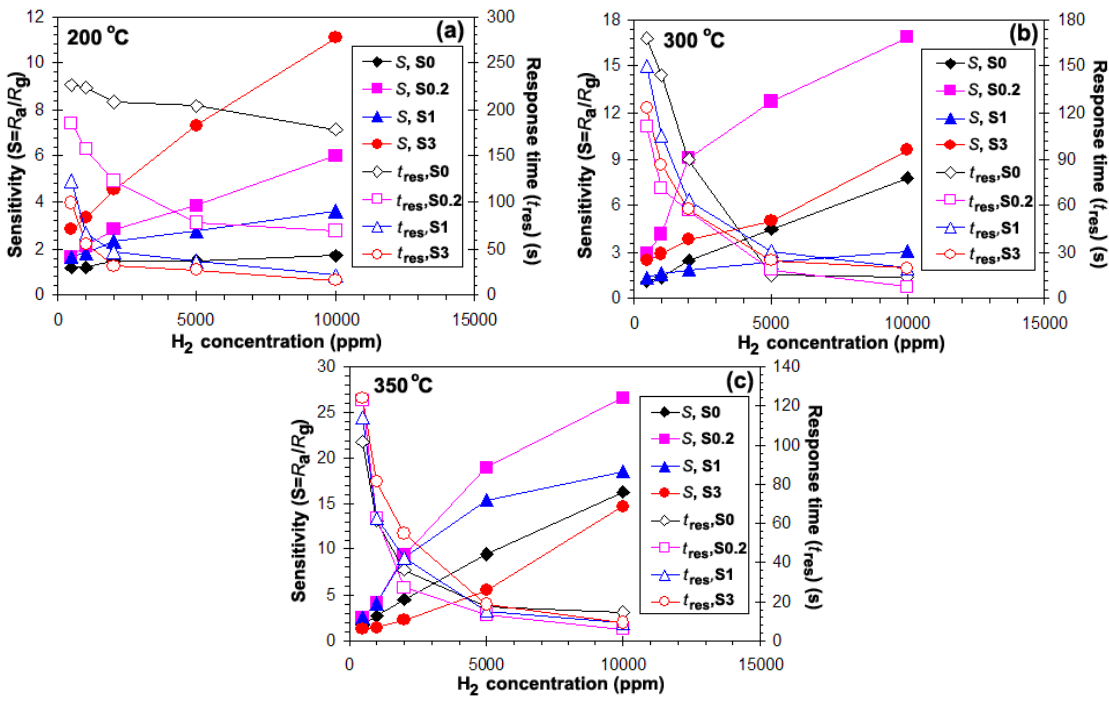
Figure 6. (a–c) Sensing performance in the terms of the sensitivity (filled symbols, left axis) and corresponding response times (open symbols, right axis) of pure SnO (S0) 2 sensors and doped with 0.2, 1, 3 wt% (S0.2, S1, S3) sensors as a function of H 2 concentration in dry air at (a) 200, (b) 300, and (c) 350 °C. The sensitivity increased and the response times decreased with increasing H 2